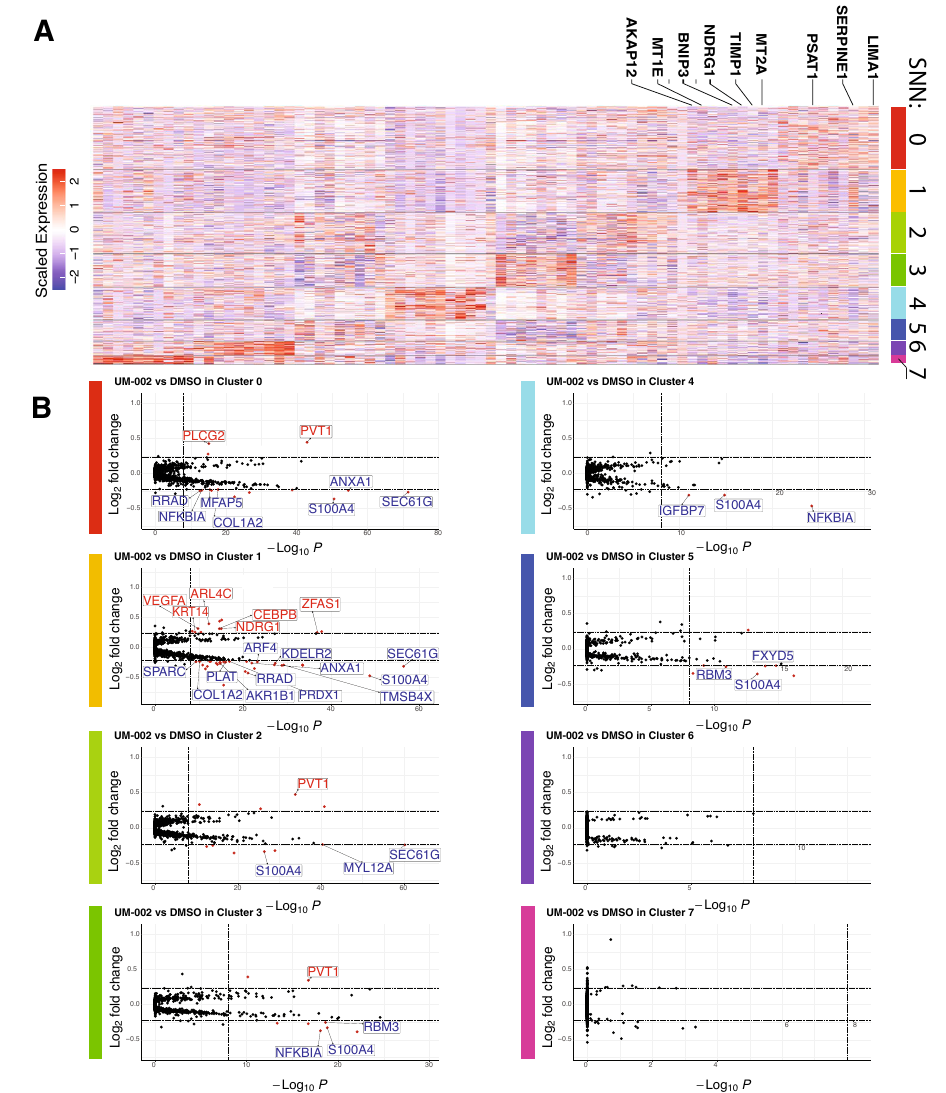
Figure 7. Single cell RNA-sequencing reveals distinct cell clusters with differentially expressed genes in response to UM-002 treatment in vivo. ( A ) Heat map of expression of top cluster defining transcripts, as determined by MAST 58 and visualized using ggplot2 44,46,49 . Labeled genes are previously published GBM cell state markers 31 found in clusters 0 and 1. ( B ) Volcano plot representation of MAST 58 differential expression within clusters between UM-002 and DMSO- treated tumors. Selected transcripts are labeled. Full differential expression results can be found in Supplementary Data S1. Points in red are upregulated with log2FC > 0.23, Bonferroni corrected p-value < 10e-9. Points in blue are downregulated with 2 log2FC < -0.23, Bonferroni corrected p-value < 10e-9. Bonferroni corrections performed using all features in our dataset. Volcano plots generated using the R 43 package EnhancedVolcano 50